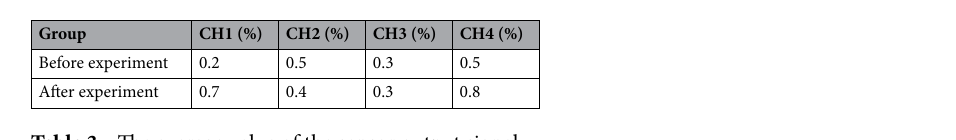
Table 3. The average value of the sensor output signal.